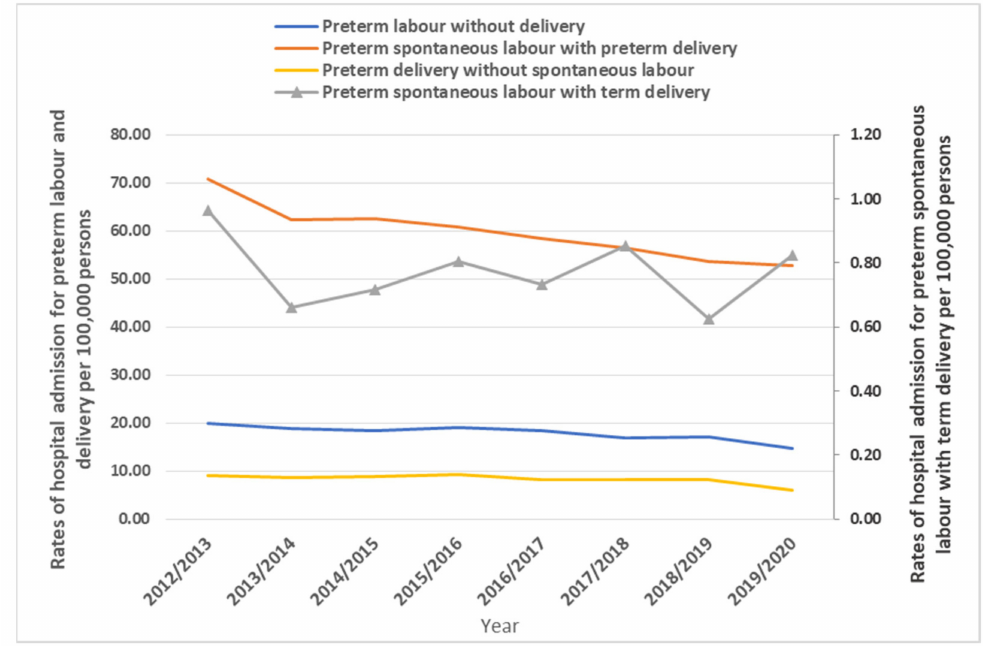
Figure 1. Hospital admission rates stratified by type between 2012 and 2020.